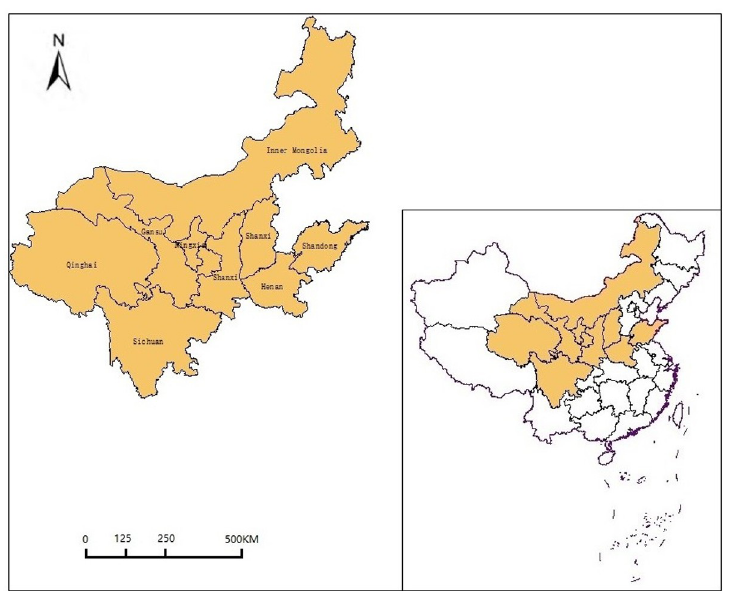
Fig 1. The geographical location of the YRB in China.